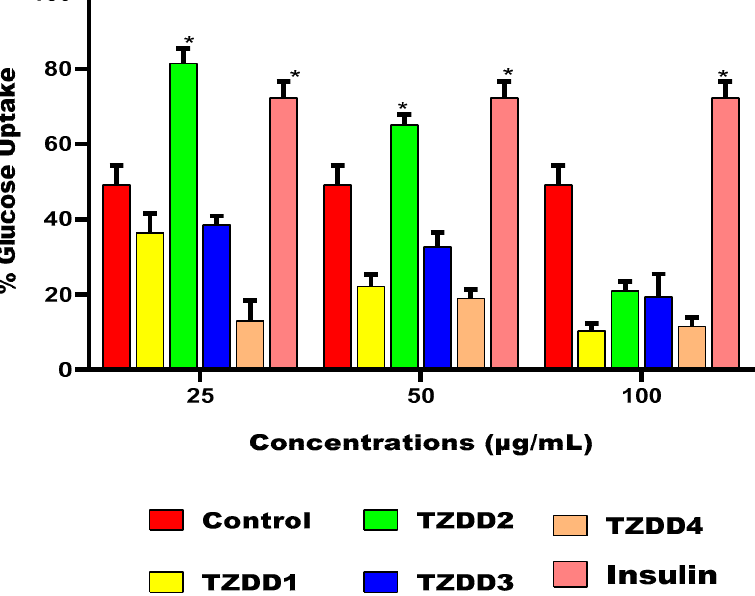
Figure 9. The results are represented in a clustered column. Data are presented as mean ± standard deviation values. The error bars correspond to the standard errors of the means, and asterisks (*) indicate a significant statistical difference relative to the control experiment ( p value ≤ 0.05).